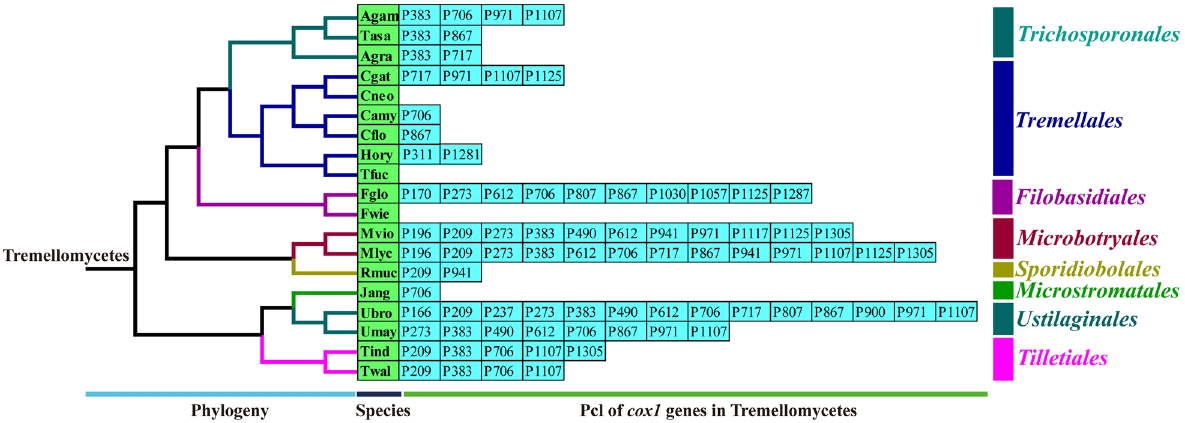
Fig. 6 Position class (Pcl) information of cox1 genes in the 19 species. Introns in cox1 genes of 19 published mitogenomes were classified into different position classes (Pcls) using the cox1 gene of Ganoderma calidophilum as the reference. Each Pcl was constituted by introns inserted at the same position of corresponding cox1 gene and named according to its insertion site in the aligned corresponding reference sequence (nt). The Pcls present in more than 1/5 of species were considered as common Pcls, while introns detected in less than 1/5 of species were considered to be rare introns. Phylogenetic positions of the 19 species were established using the Bayesian inference (BI) method and Maximum Likelihood (ML) method based on combined mitochondrial data sets. Species information is shown in Additional file 1: Table